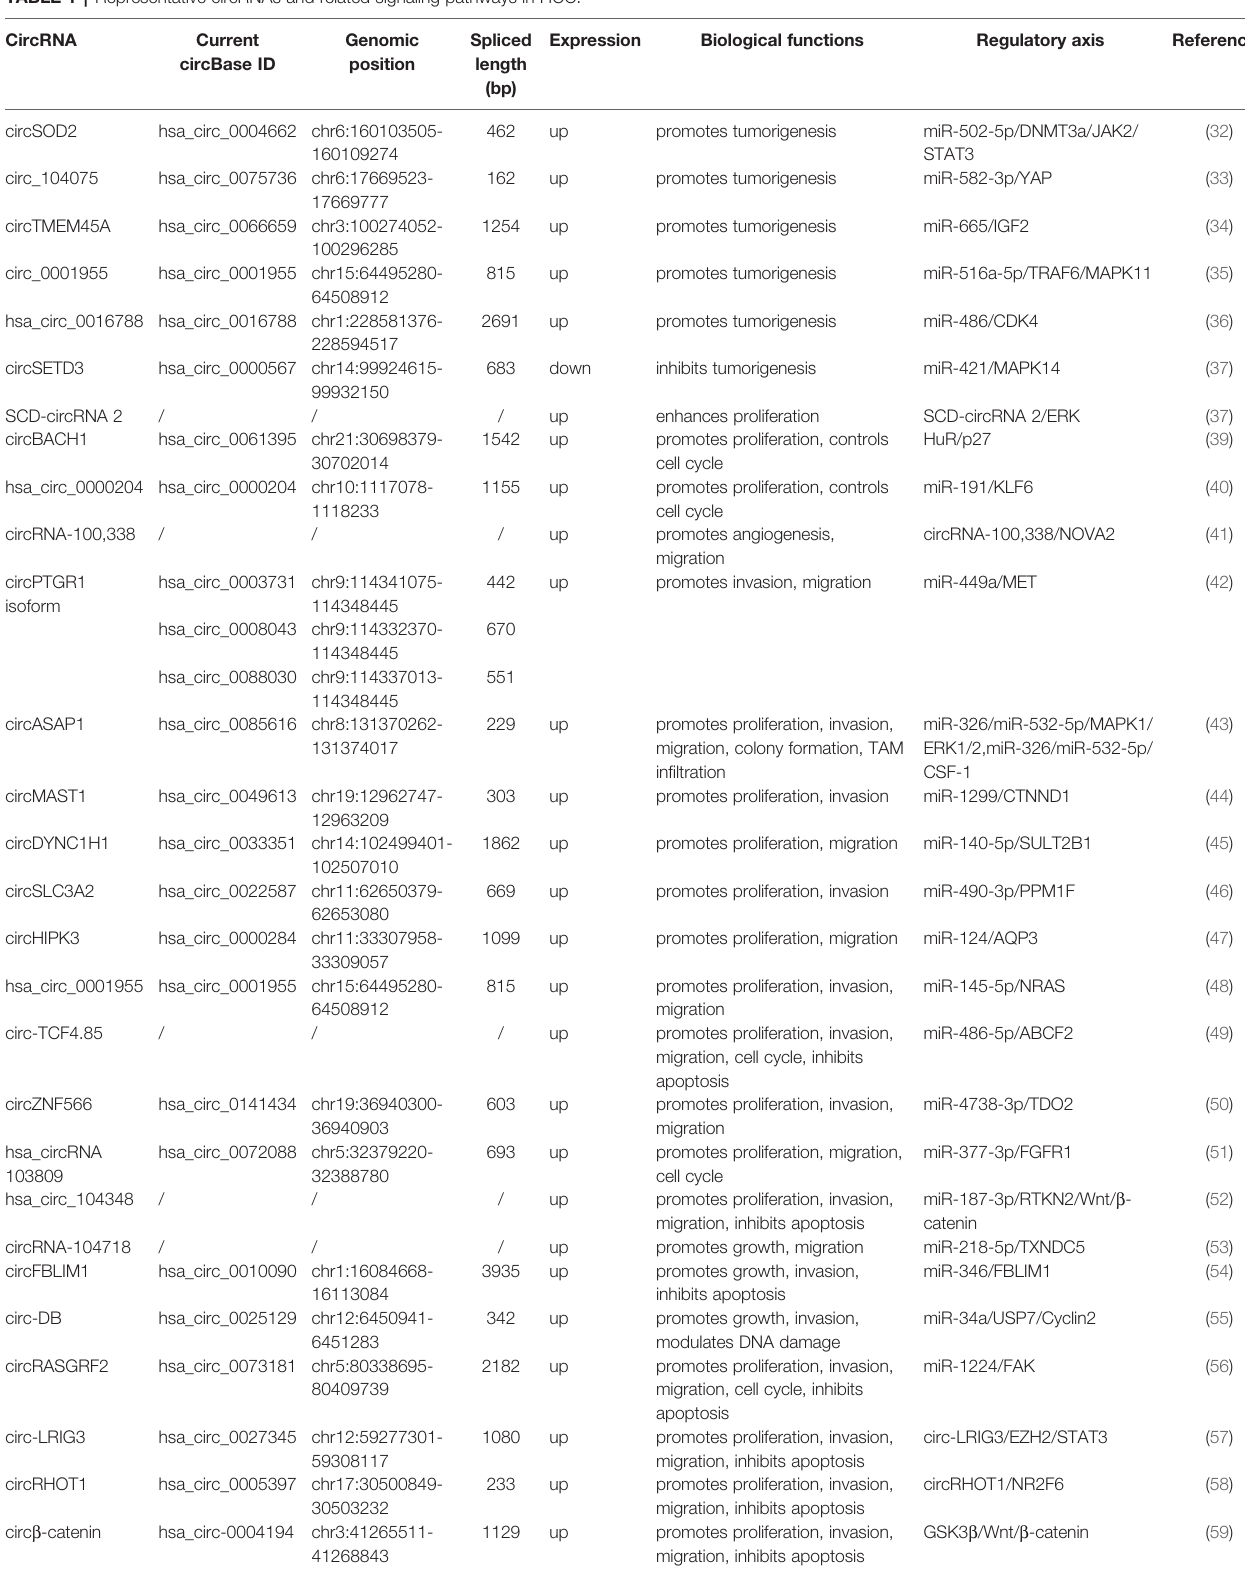
TABLE 1 | Representative circRNAs and related signaling pathways in HCC.